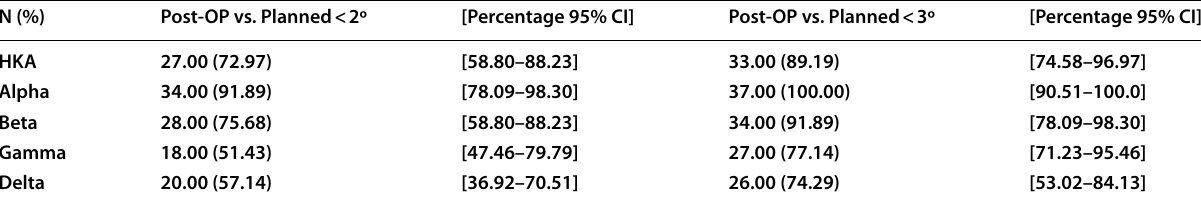
Table 2 Proportion of Cases within 2 and 3° of the intra-operative plan for bone resection angles N